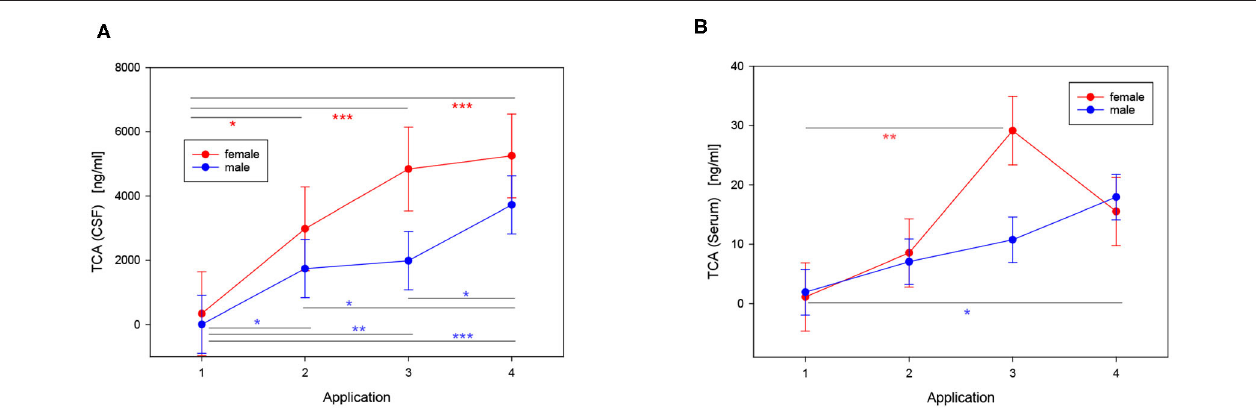
FIGURE 1 | Effects of repeated intrathecal TCA injections in male (blue) and female (red) MS patients on TCA concentrations in CSF (A) and serum (B) (LS-means ± SE). The injections were performed in treatment cycles consisting of 4 consecutive applications with 2-day intervals. The peak in (B) is driven by an outlier in the data ( Supplementary Table 1 ) that presumably resulted from a traumatic lumbar puncture (pairwise multiple comparisons with the Tukey-Kramer procedure: * p < 0.05; ** p < 0.01; *** p < 0.001; n cycles = 20: 6 cycles of 2 females, 14 cycles of 4